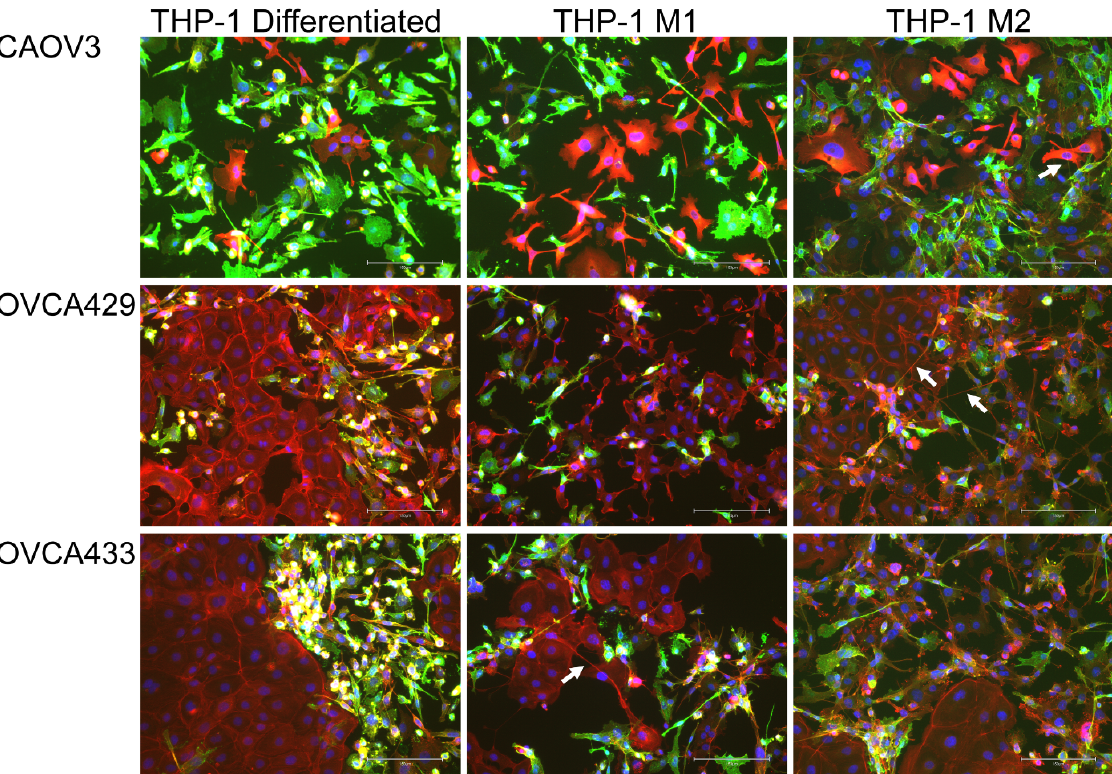
Figure 2. Macrophages alter cellular morphology of ovarian cancer cells during co-culture. THP-1 cells were differentiated and/or differentiated followed by subsequent polarization to M1 and M2 macrophages. After differentiation/polarization CAOV3, OVCA429, and OVCA433 cells were cultured with differentiated THP-1, M1, and M2 polarized macrophages for 48 h. Cultures were stained for CD14 to denote THP-1 derived cells (green), Texas Red Phalloidin as a marker of F-actin (red), and DAPI (blue). 20× original magnification. Scale bar = 150 µm. Arrow = denotes membrane projections produced between tumor cells.